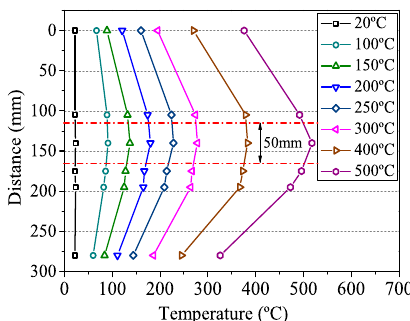
Figure 4. Constant temperature distribution on the surface of CFRP tendons.